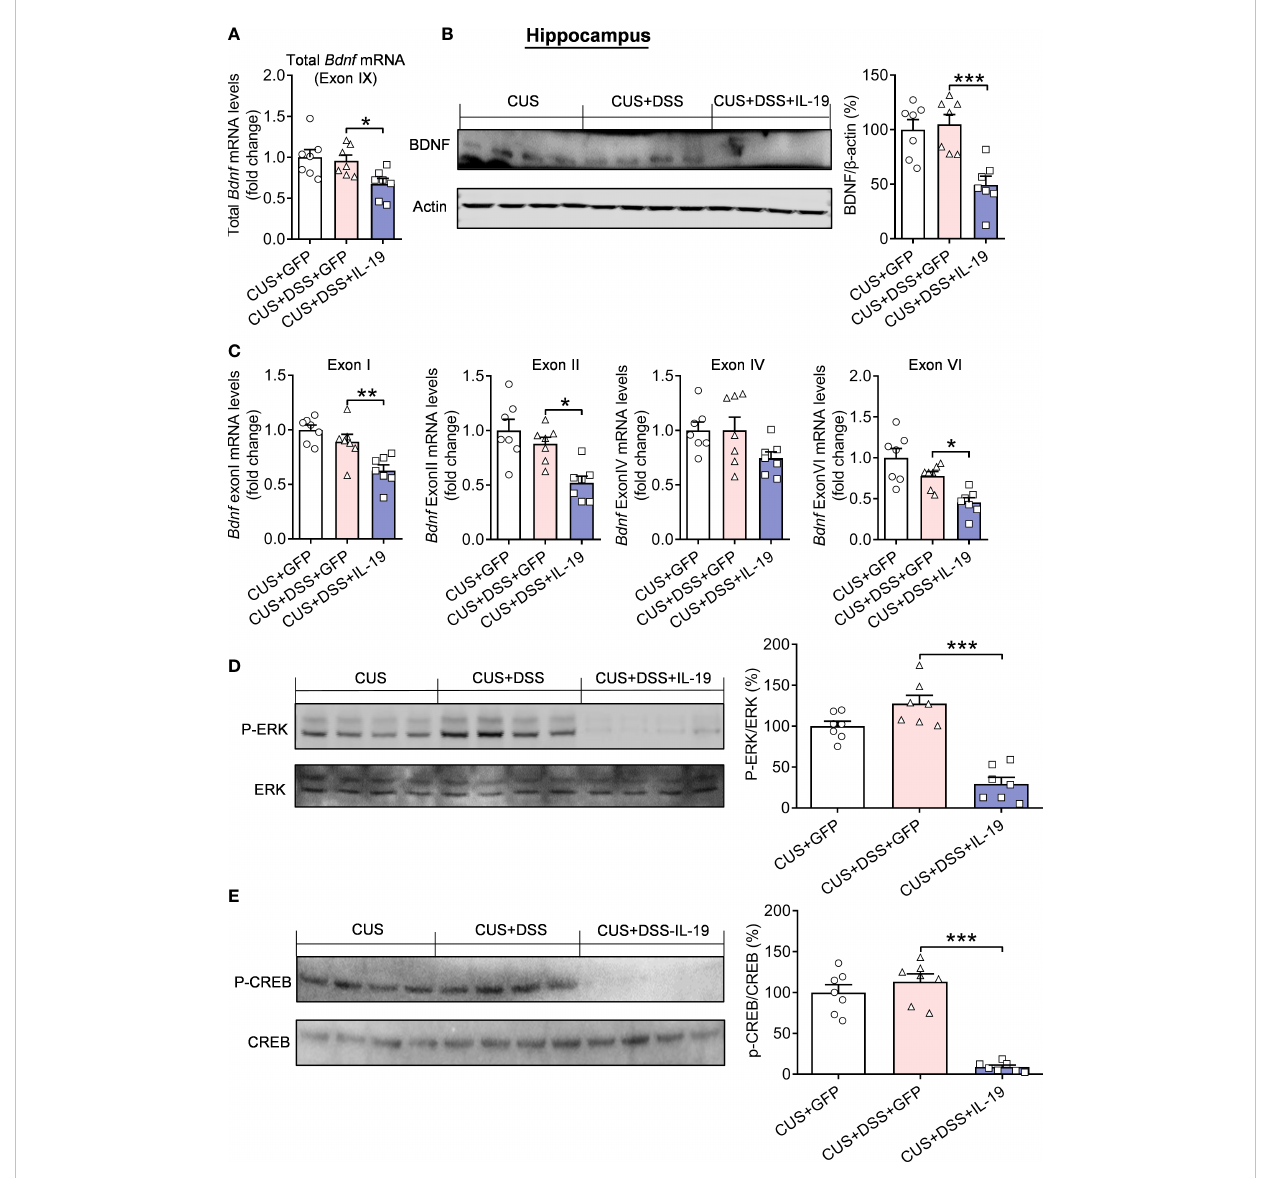
FIGURE 8 Regulation of hippocampal ERK-CREB-BDNF pathway by colonic IL-19 overexpression in the DSS/CUS treated mice. (A) The mRNA and (B) protein levels of BDNF in the hippocampus. (C) The mRNA levels of BDNF-speci fi c exons. (D) p-ERK and p-CREB levels in the hippocampus. CUS + GFP group: n=7, CUS+DSS+GFP group: n=7, CUS+DSS+IL-19 group: n=7. * p < 0.05, ** p < 0.001, *** p < 0.001, compared to the control